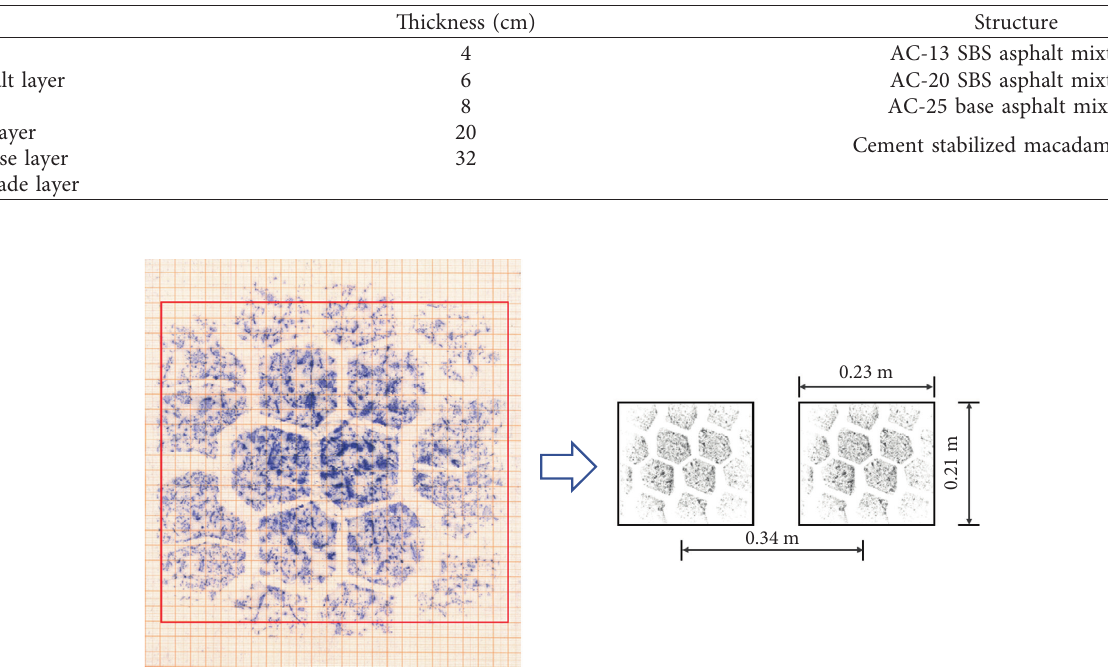
Figure 1: Load size and contact